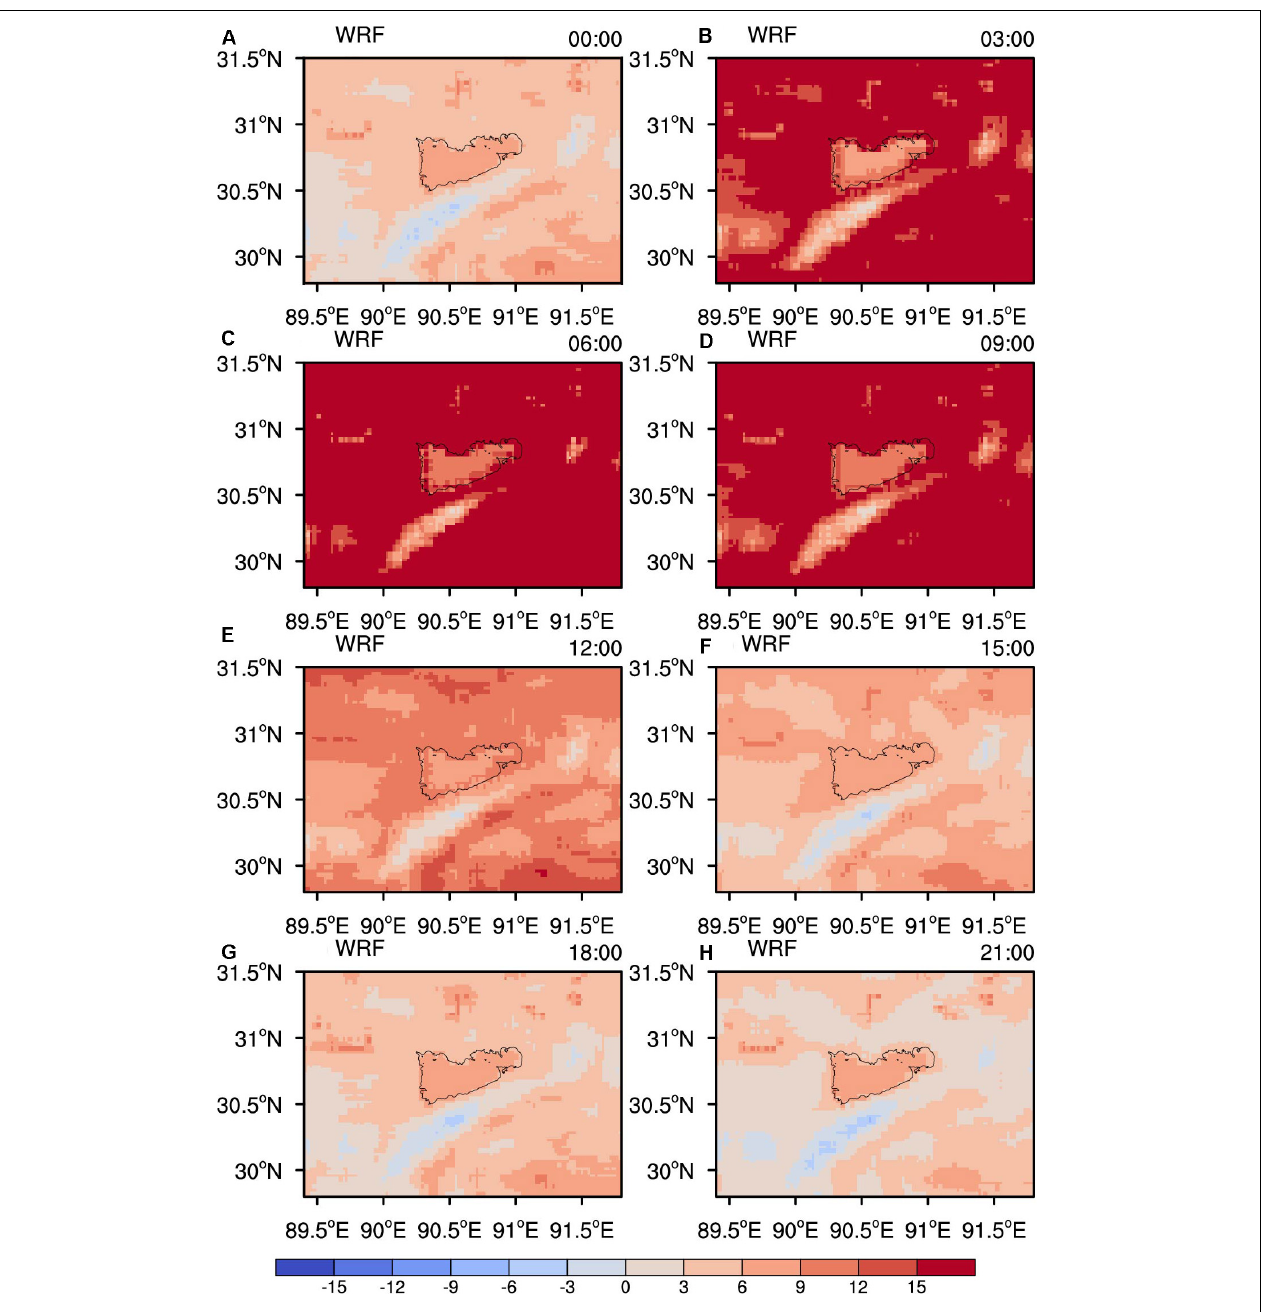
FIGURE 7 | Spatial pattern of monthly mean 3-h TSK ( A–H , shading, units: ◦ C) of WRF_lake simulation in July 2008.